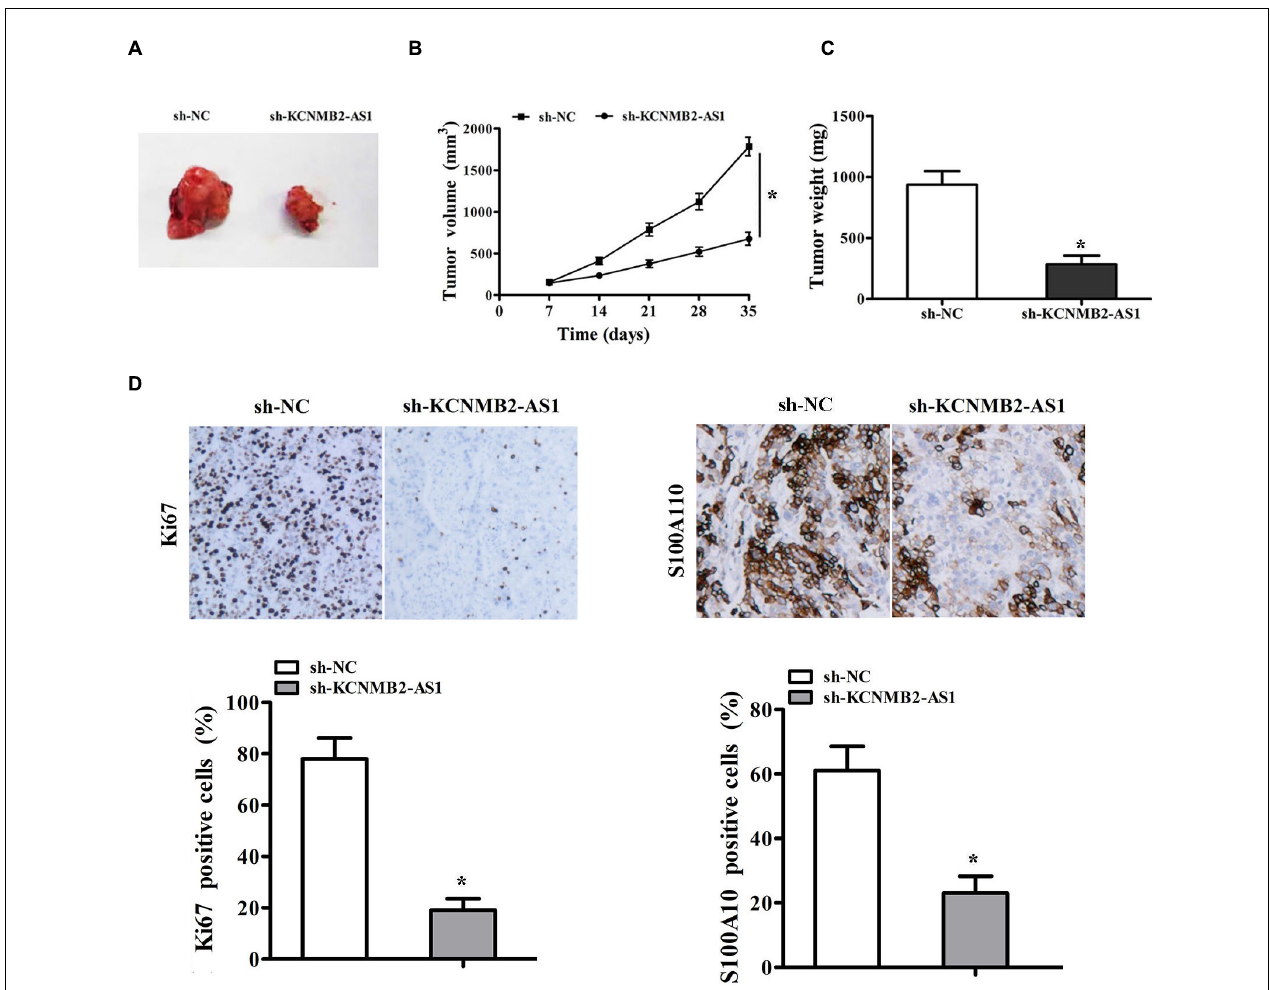
FIGURE 6 | KCNMB2-AS1 knockdown inhibited BC cell growth in vivo. T24 cells transfected with sh-KCNMB2-AS1 or sh-NC were subcutaneously injected into nude mice to establish xenograft models. (A) Representative images of tumors. (B,C) The volume and weight of tumor xenografts. (D) Immunohistochemistry analysis of Ki-67 and S100A10 protein levels. Data were showed as mean ± standard deviation. Tumor volume at different time points was analyzed by repeated measures ANOVA, n = 4 for mice upon each treatment. * P <